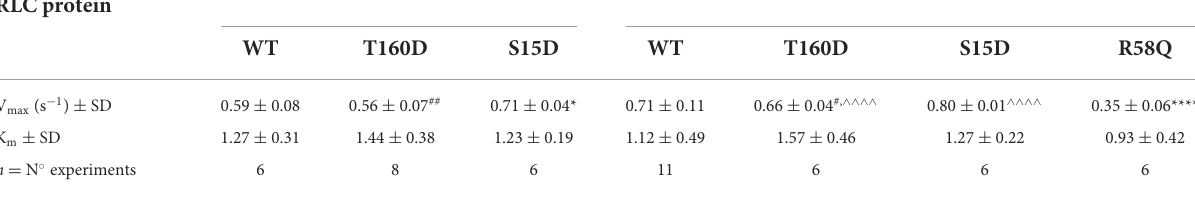
TABLE 1 Summary of actin-activated myosin ATPase activity